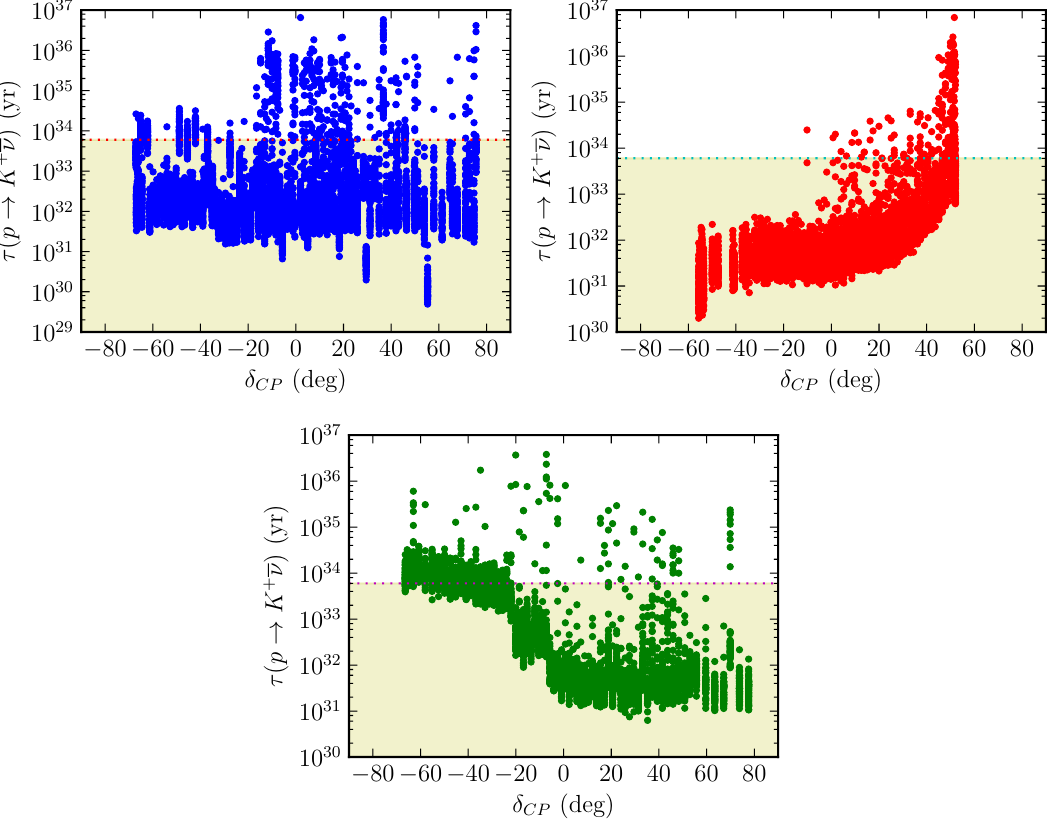
Figure 7 . Comparisons of the Dirac CP phase angle to the K + (cid:22) (cid:23) partial lifetime, for the fermion (cid:12)ts discussed